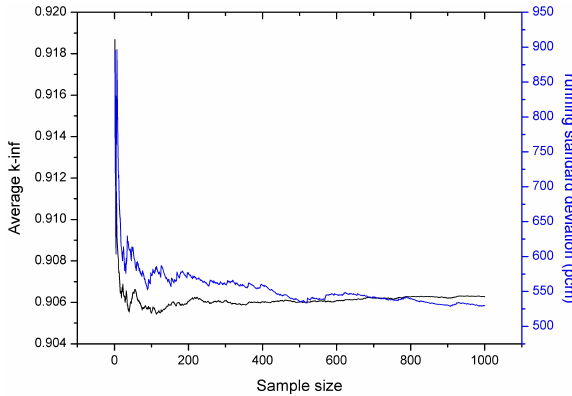
Figure 3. Running k viation as function of sample size for simulation on